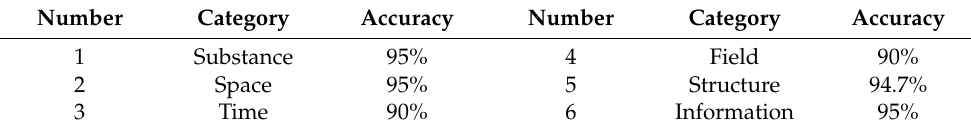
Table 5. Accuracy of engineering parameter sequence training in each